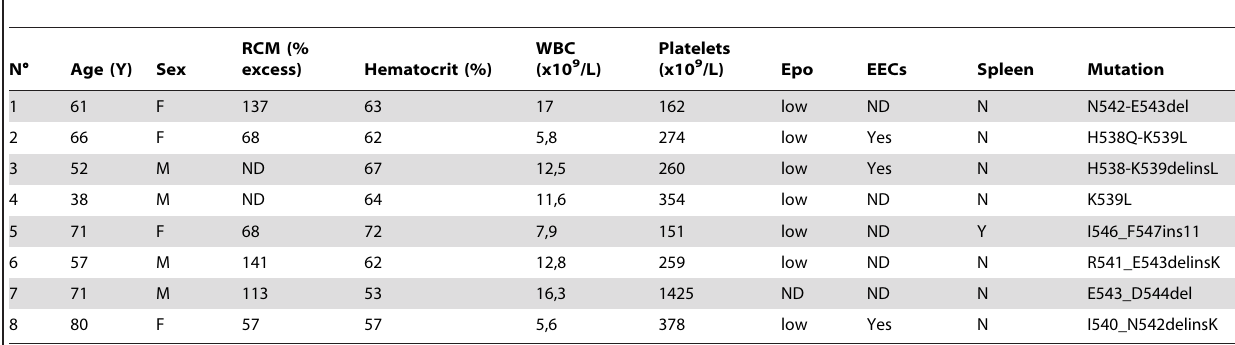
Table 1. Clinical and biological data of 8 patients with exon 12 mutations tested in 4 laboratories (RCM: Red cell mass. ND: Not